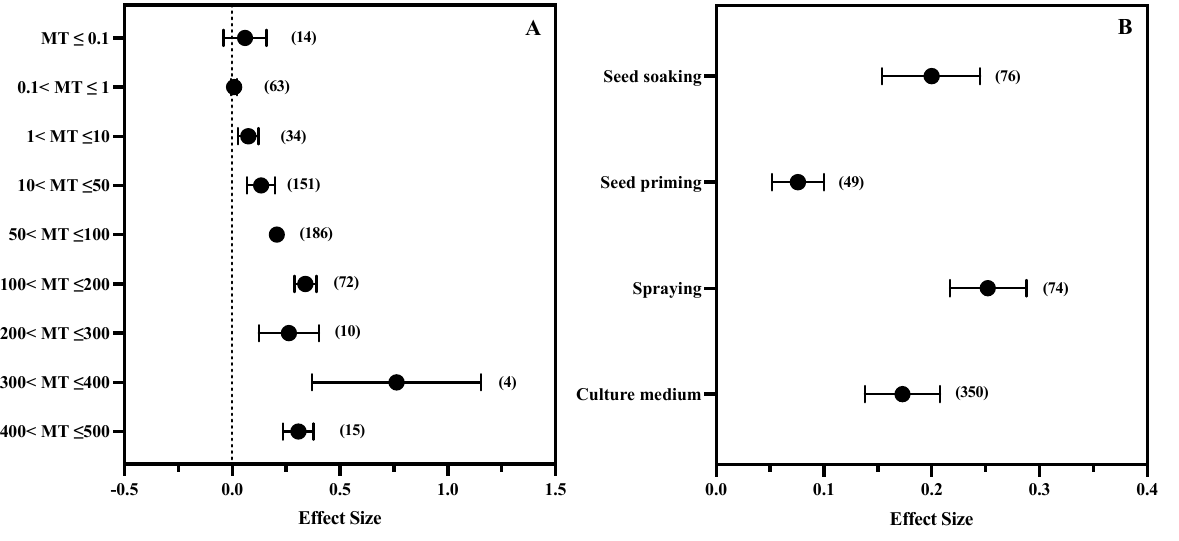
Figure 6. Effects of MT concentration ( A ) and application method ( B ) on the protective effects of MT in plants. The symbol represents the effect size, and the bars show the 95% bootstrapped confidence intervals. The values in the parentheses show the number of observations.